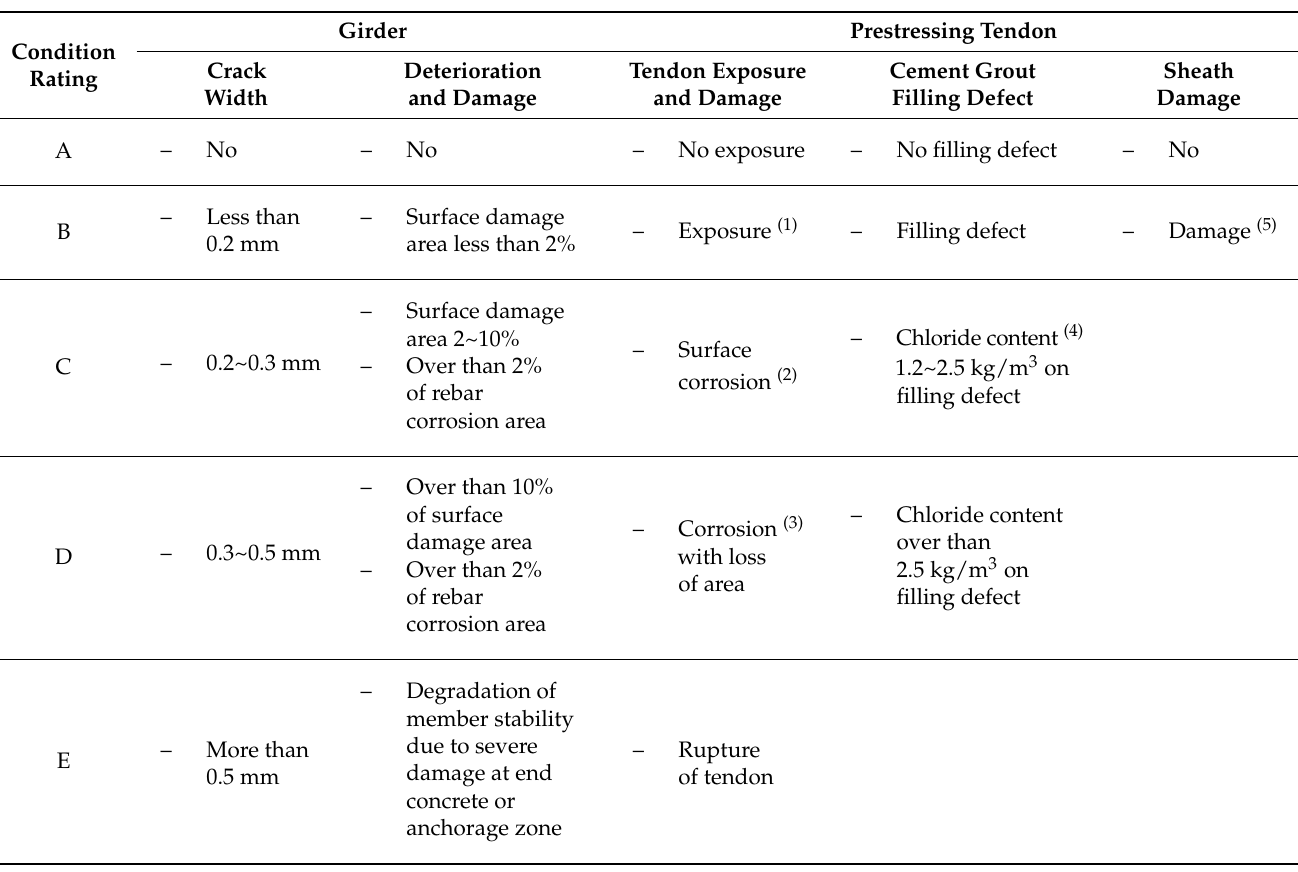
Table 3. Condition rating system for girders.